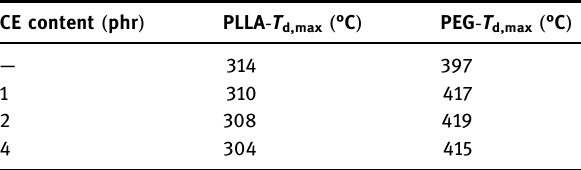
Table 3: T d,max of in situ chain - extended PLLA - PEG - PLLA